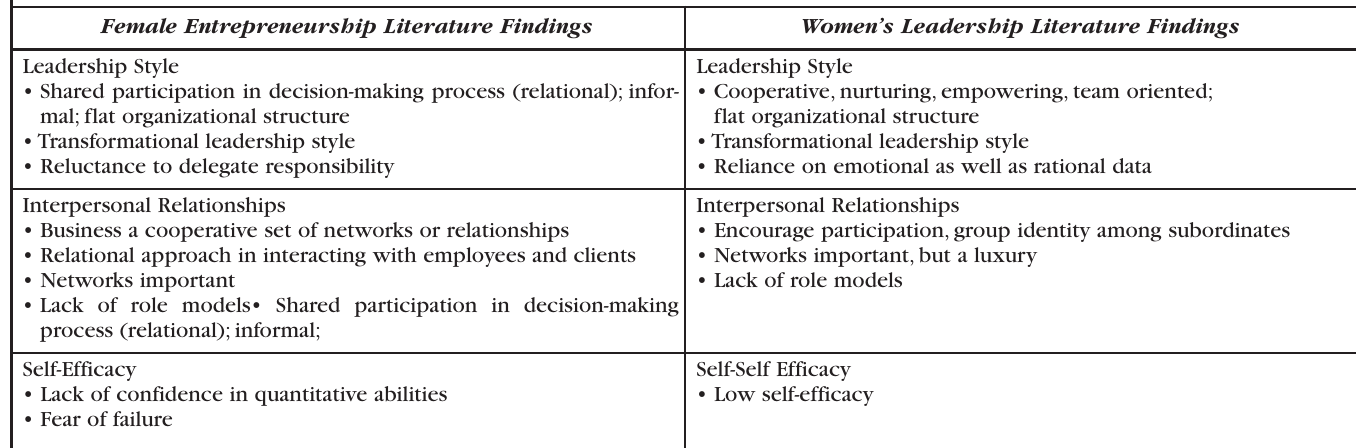
Table 2. Female Entrepreneurship and Women’s Leadership Commonalities Female Entrepreneurship Literature